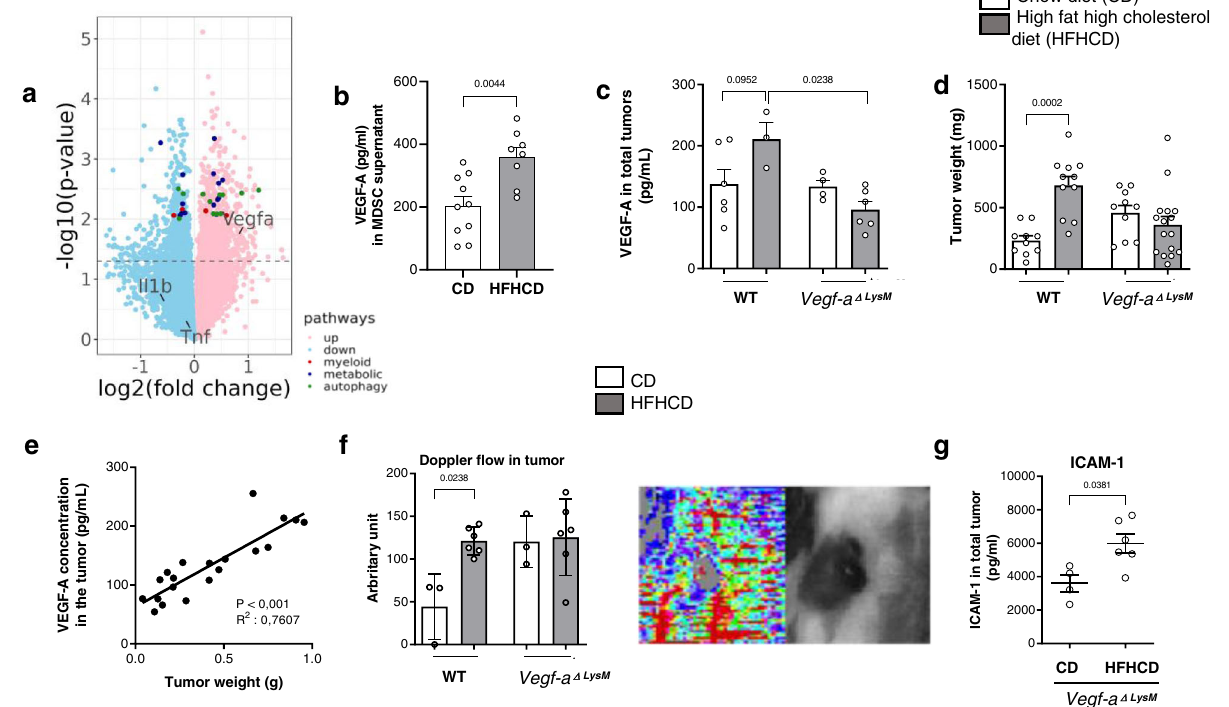
Fig.5|Myeloid-derivedVEGF-AcontrolstumorgrowthunderHFHCD. C57BL/6J mice, fed with CD or HFHCD and grafted with B16-F10 cells. a Volcano plot of all expressed genes, with Vegfa and differentially expressed genes from signi fi cantly enrichedpathwayhighlighted. b MDSCswereisolatedfromB16-F10tumoratday13 aftertumorgraft,andculturedfor18hincompletemedium.VEGF-Awasmeasured bybead-basedmultipleximmunoassayinthesupernatant( n =10miceinCDgroup, n =8 miceinHFHCD group). c – e LysMCre +/ − / Vegf-a f/f ( Vegf-a Δ LysM ) and their control littermate LysMCre − / − /Vegf-a f/f (WT) mice were fed for 2 weeks with CD or HFHCD, and were transplanted with B16-F10 cells (s.c.). Mice were sacri fi ced at day 15 post injection. c VEGF-Aproductionin totaltumors wasmeasured byELISA( n =6inWT mice on CD, n =3 in WT mice on HFHCD, n =4 in Vegf-a Δ LysM mice on CD, n =6 in Vegf-a Δ LysM mice on HFHCD). d Tumors weight ( n =10 in WT mice on CD, n =11 in WT mice on HFHCD, n =10 in Vegf-a Δ LysM mice on CD, n =16 in Vegf-a Δ LysM mice on HFHCD, two independent experiments combined. Analysis of difference within